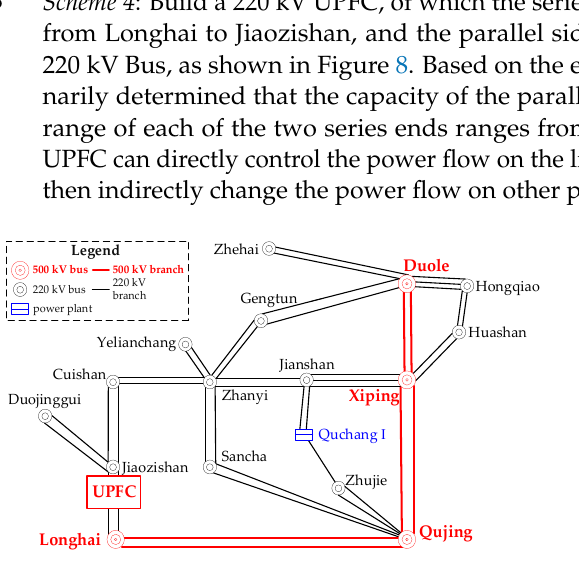
Figure 8. Sketch map of Scheme 4.